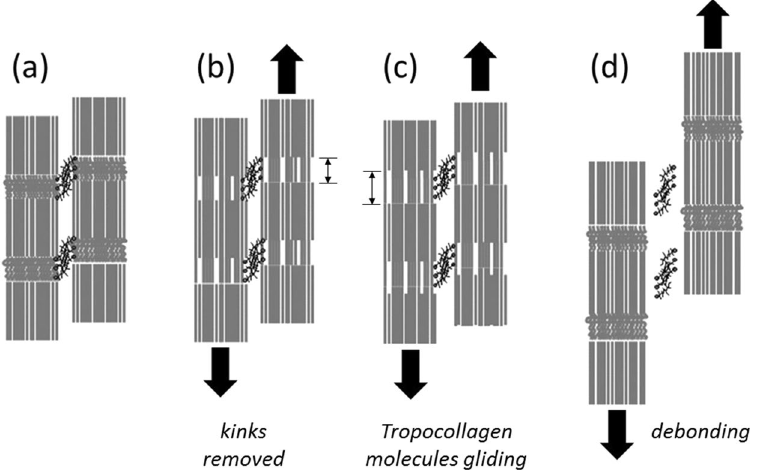
Figure 5. Proposed fibrillar level deformation and failure model as a schematic. One unit cell consists of two fibrils connected with GAGs side chains (black mesh). Each fibril is made up of a collection of staggeredly oriented tropocollagen molecules (grey individual lines). ( a ) Unloaded state. ( b ) Toe region - Removed kinks in the gap regions of collagen fibrils. ( c ) Linear region - Tropocollagen molecules starts to glide past each other. ( d ) Debonded stiff matrix from collagen